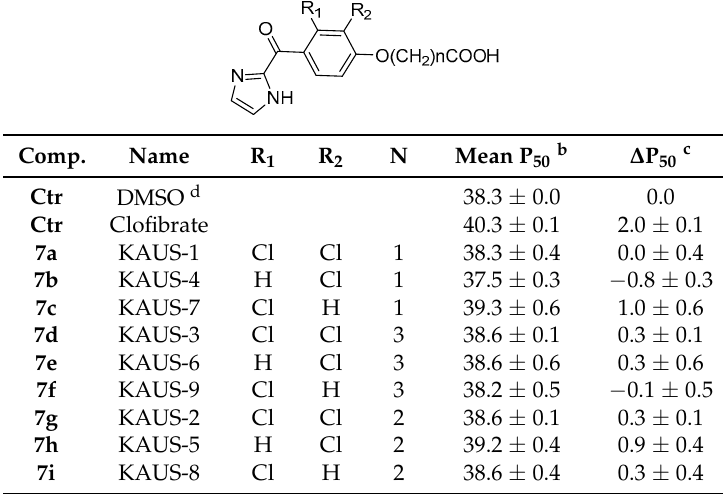
Table 2. The Effect of Compounds ( 13 , 17a – e , 21a – c ) on Hb Affinity for Oxygen Using Normal Whole Blood a .